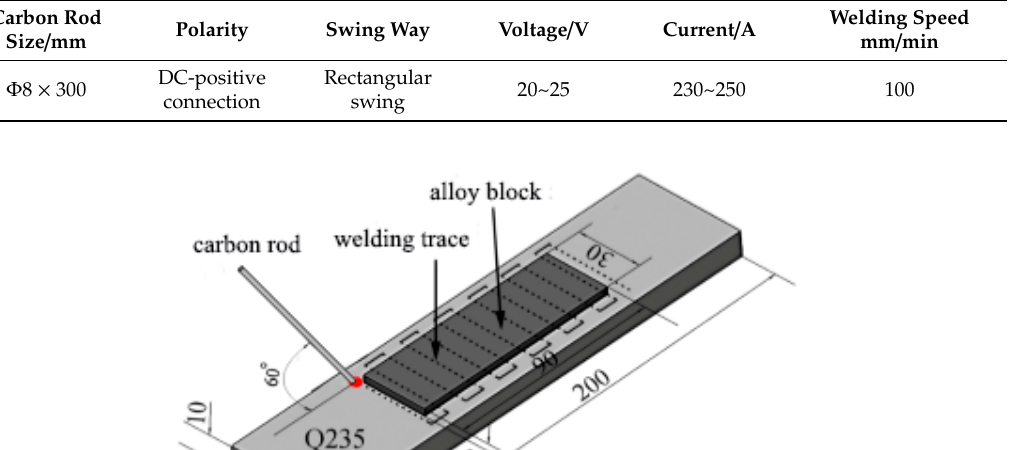
Table 3. Technological parameter of carbon arc surfacing.